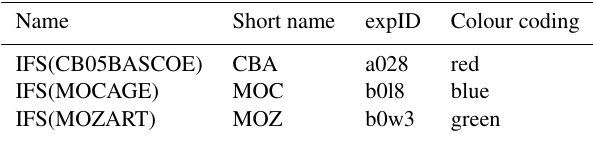
Table 3. Specifications of the experiments